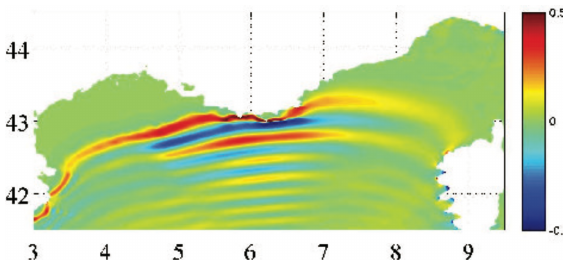
Figure 9. Map of the French Mediterranean coast (close to the HFR- Tln system) within the simulated surface elevation (in meters) after 1h 10min propagation for a tsunami generated by a M 7 . 8 seismic source on the northern Algerian margin. The numerical simulation uses FUNWAVE-TVD software with three nested grids in the west- ern Mediterranean basin (courtesy of Stephan Grilli, University of Rhode Island,